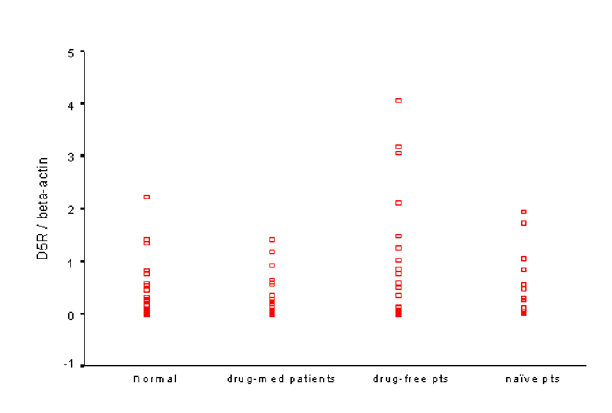
Figure 5 D5R/ β A mRNA among study groups. There were simi- lar findings with figure 3, but there is no significant difference among